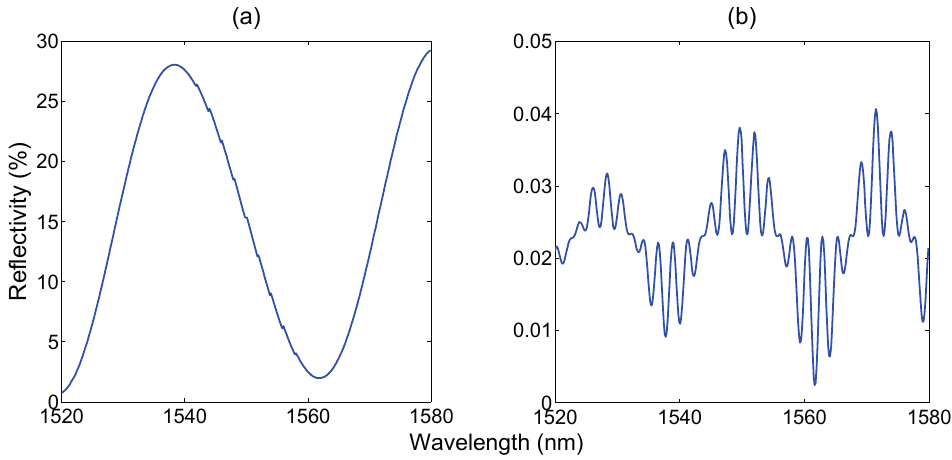
Figure 16. Eigenvalue filtering to retrieve the FPI sensors spectra. ( a ) Spectrum